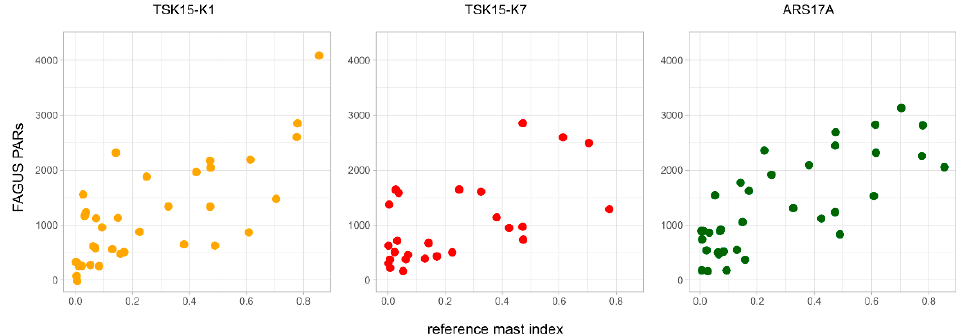
Table 3. Correlation coefficients and gleichläufigkeit between annual pollen deposition of F AGUS and P ICEA in three lake pollen records and the reference mast index as well as the tree-ring records.